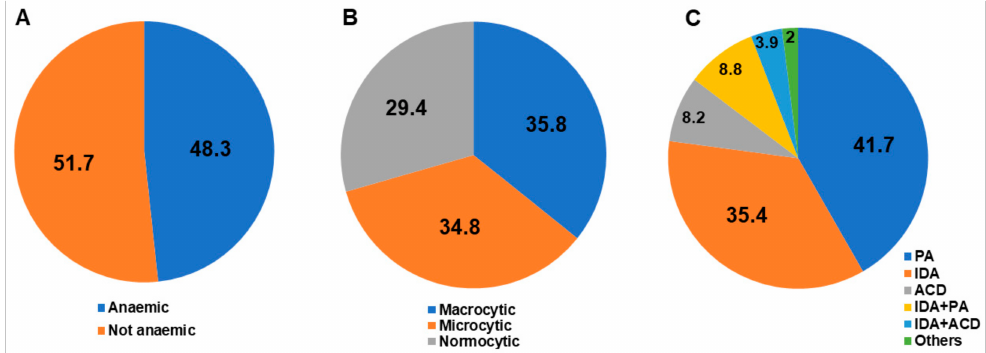
Figure 2. The study population includes 654 adult patients su ff ering from autoimmune atrophic gastritis. The figure shows the proportion of patients with and without anaemia ( A ), the distribution of mean corpuscular volume (MCV) in anaemic patients ( B ), and subtypes of anaemia ( C ). The category “Others” includes chronic kidney failure and neoplastic diseases. Abbreviations: ACD, anaemia of chronic disease; IDA, iron deficiency anaemia; PA, pernicious anaemia. Table 3. Clinical, haematological, and histological variables of patients with autoimmune atrophic gastritis (AAG) according to the presence or absence of anaemia (any type). Presence of Anaemia Absence of Anaemia p -Value 220 / 459 (47.9) 239 / 459 (52.1)